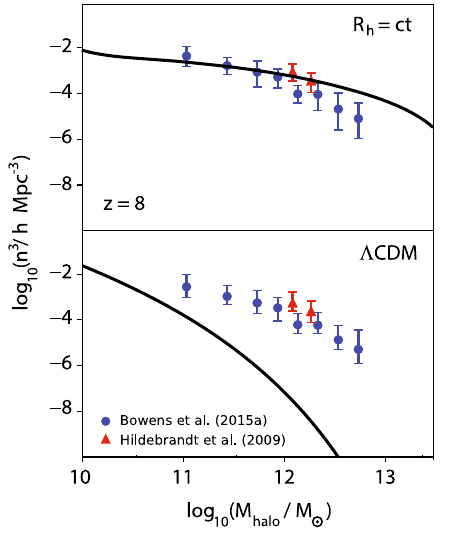
Fig. 5 Top: halo mass function inferred from galaxy surveys at z = 8 compared with R h = ct . Bottom: same, except now for Λ CDM